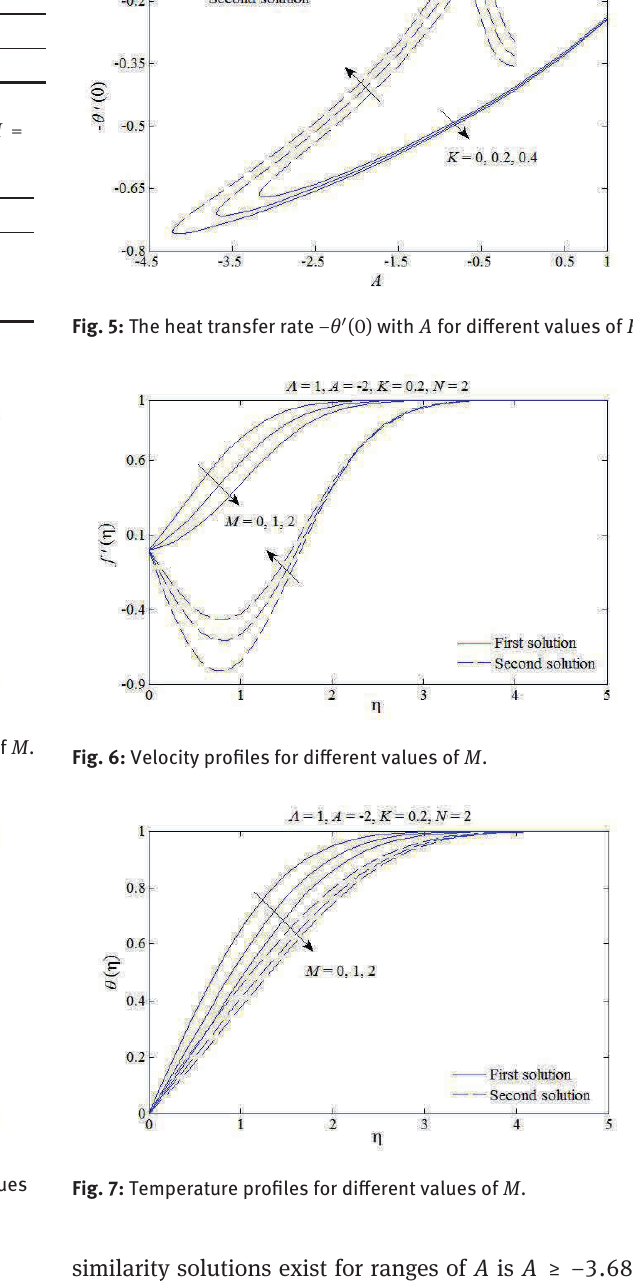
Fig. 7: Temperature profiles for different values of M